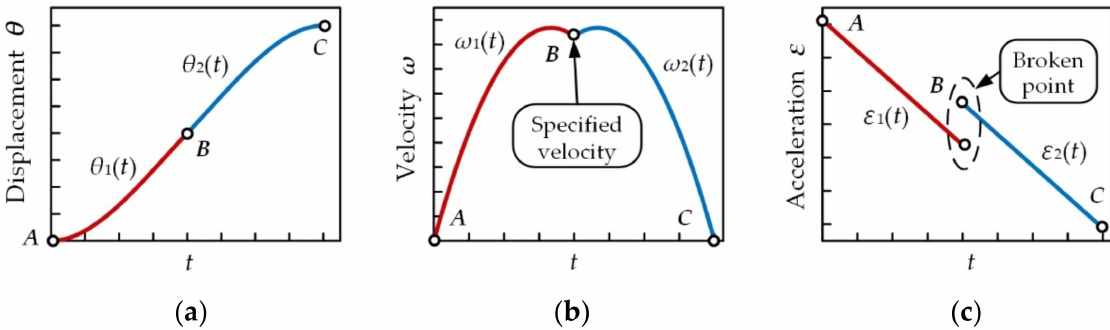
Figure 4. Velocity-constrained PTP motion planning by cubic polynomial interpolation: ( a ) Angular displacement planning; ( b ) Angular velocity planning; ( c ) Angular acceleration